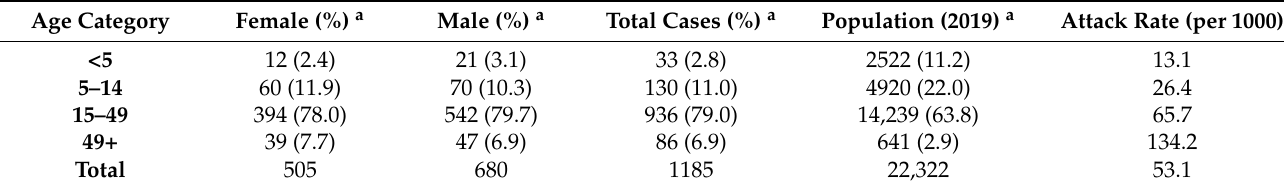
Table 1. Age-specific DF attack rates in Gewane District, Afar Region, Ethiopia ( n = 1185).